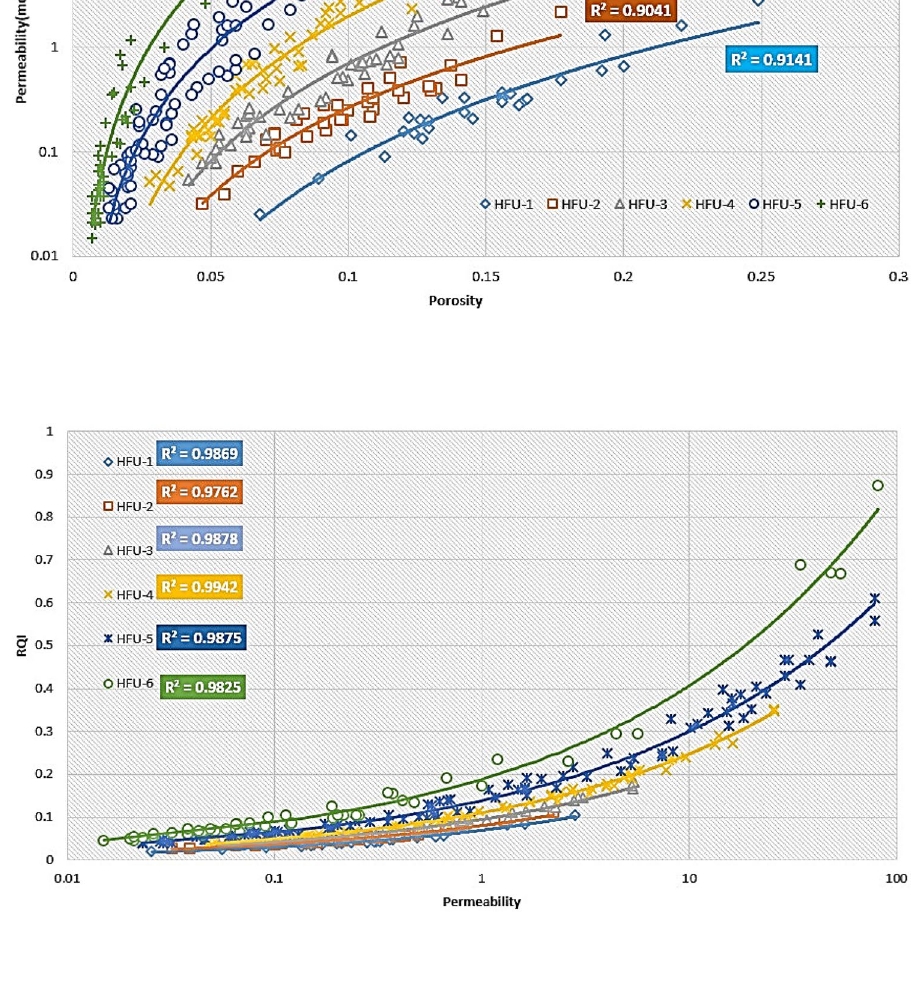
Fig. 17 Relationship between Porosity vs. RQI